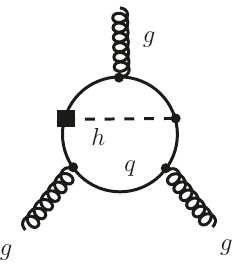
Figure 1 . The contributions to the Weinberg operator are suppressed with respect to the dipole contributions by an additional power of a light-quark Yukawa and are neglected. Here and in the fol- lowing, the CP-violating Higgs coupling to the light quarks q = u; d; s is denoted by a black square.